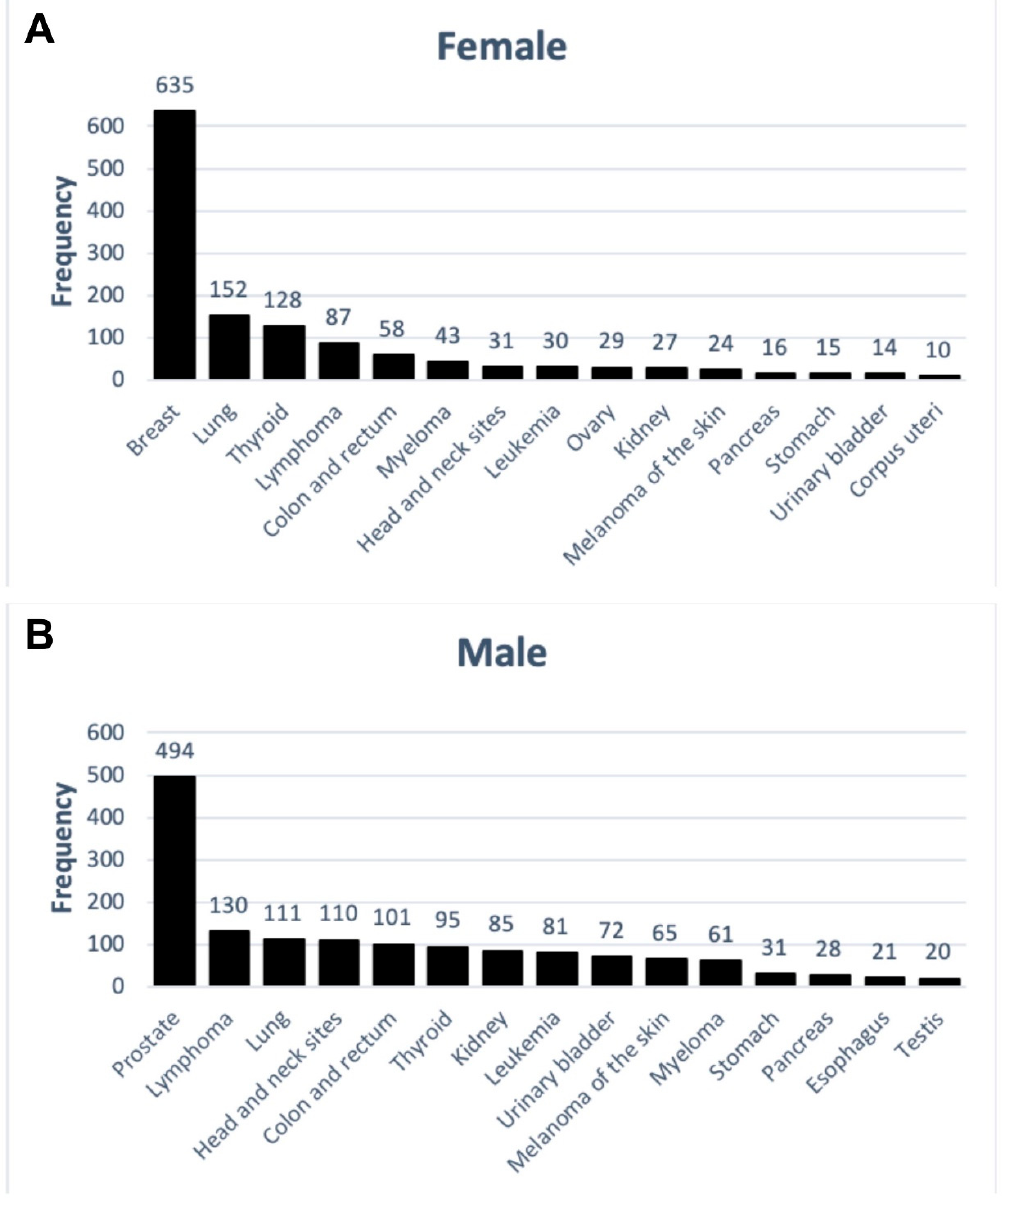
Figure 4. Frequency of top fifteen solid cancer diagnoses in female ( A ) and male ( B ) patients.